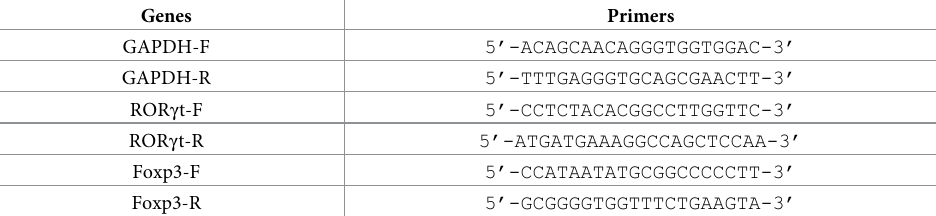
Table 1. List of primers used for quantitative real-time